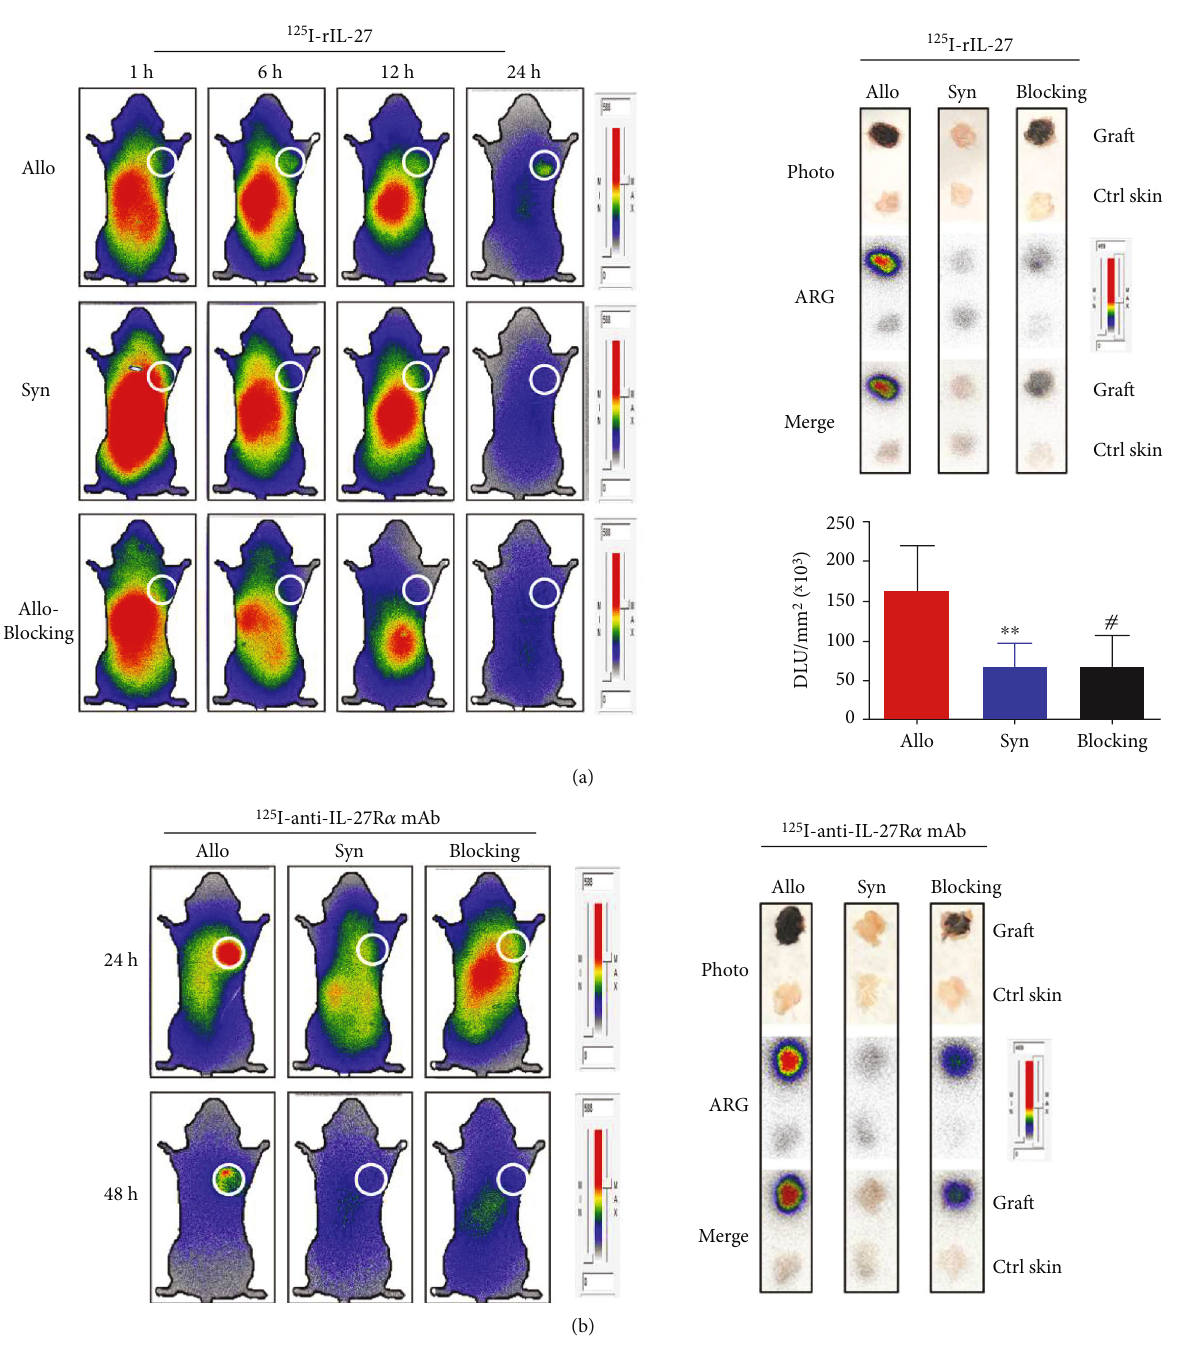
Figure 3: Dynamic whole-body phosphor autoradiography imaging